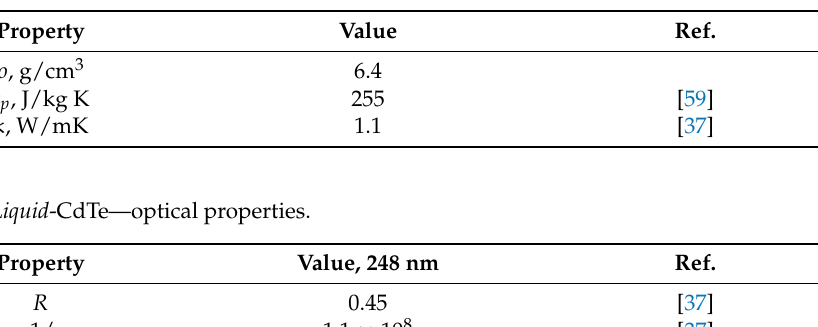
Table A15. Liquid -CdTe—thermophysical properties.